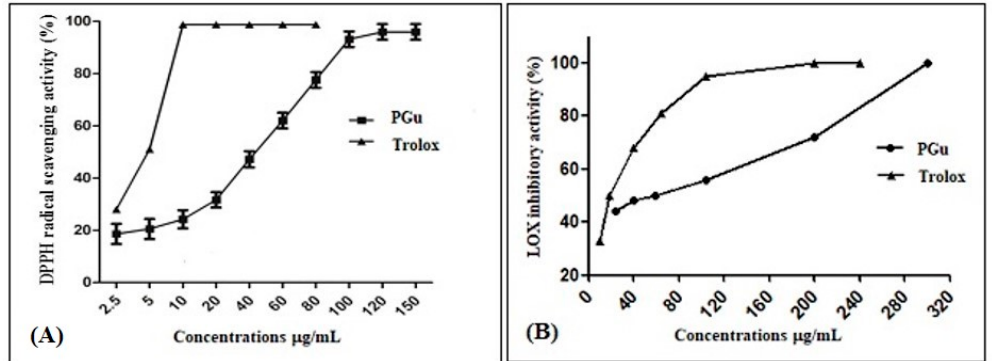
Figure 2. The radical scavenging activity of PGu (Pinoresinol-4- O - β - D -glucopyranoside) on the